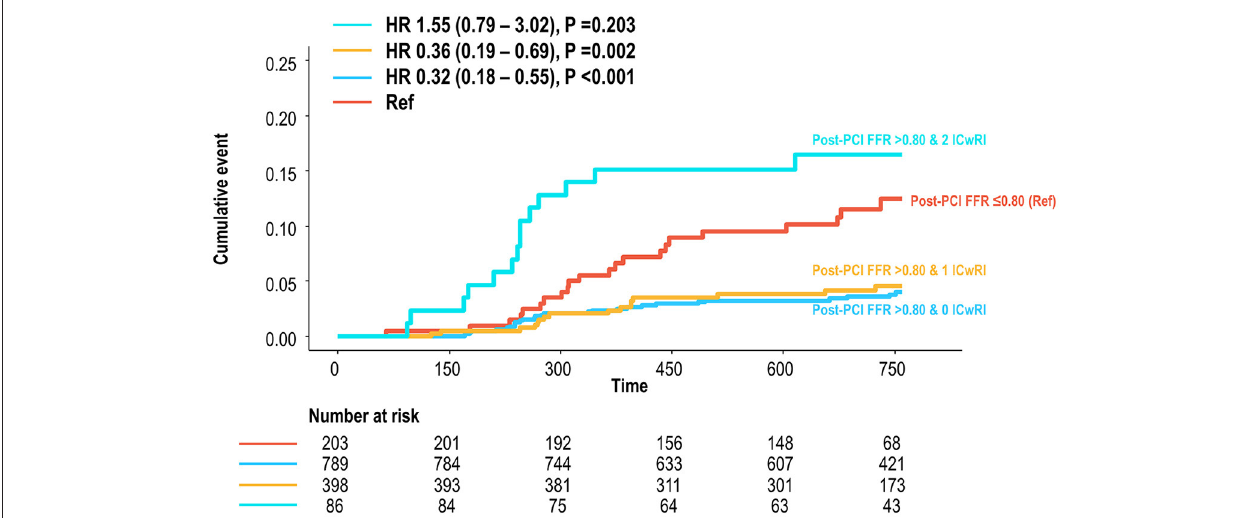
FIGURE 5 | Cumulative incidence of TVF according to the number of ICwRI in patients without residual ischemia compared to those with residual ischemia. Patients with post-PCI FFR > 0.80 were classified according to the number of ICwRI. The TVF risk for each group was then compared to that of patients with a post-PCI FFR of ≤ 0.80. The ICwRI definitions are shown in Figure 3 . FFR, fractional flow reserve; HR, hazard ratio; ICwRI, interaction characteristics with residual ischemia; PCI, percutaneous coronary intervention; TVF, target vessel